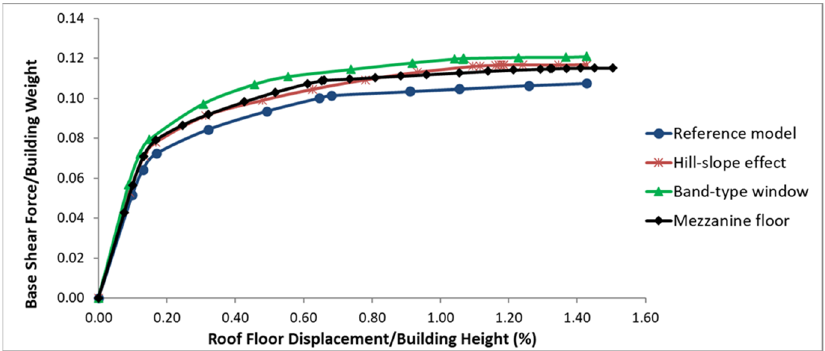
Figure 11. Comparison of capacity curves.